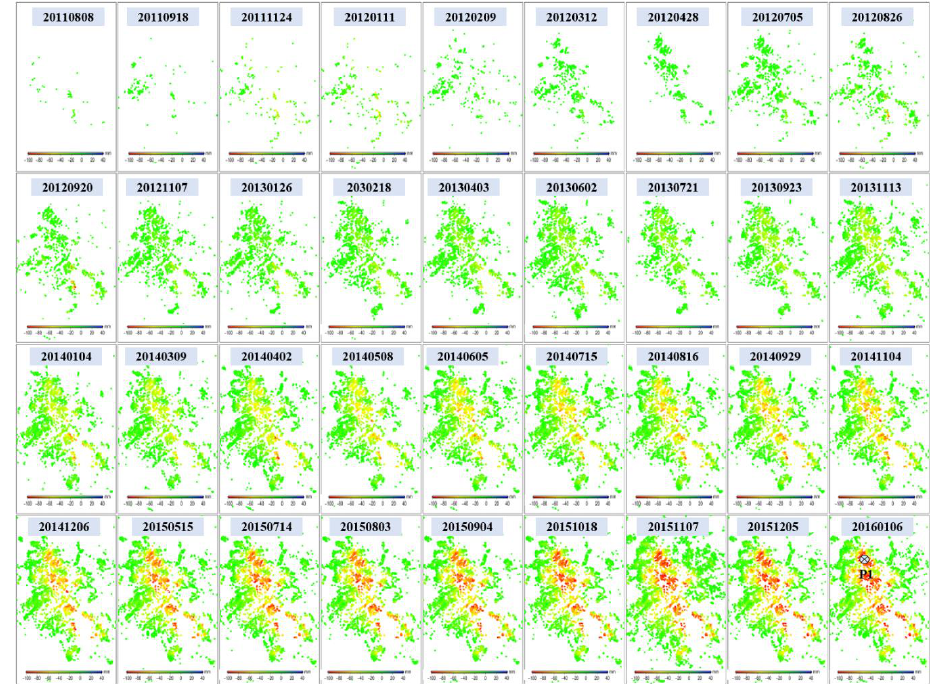
Figure 11. Time series deformation in Guandu (marked with black rectangles in Figure 5) observed using X-band COSMO-SkyMed images. The time series deformation at point P1 will be extracted for further analysis.